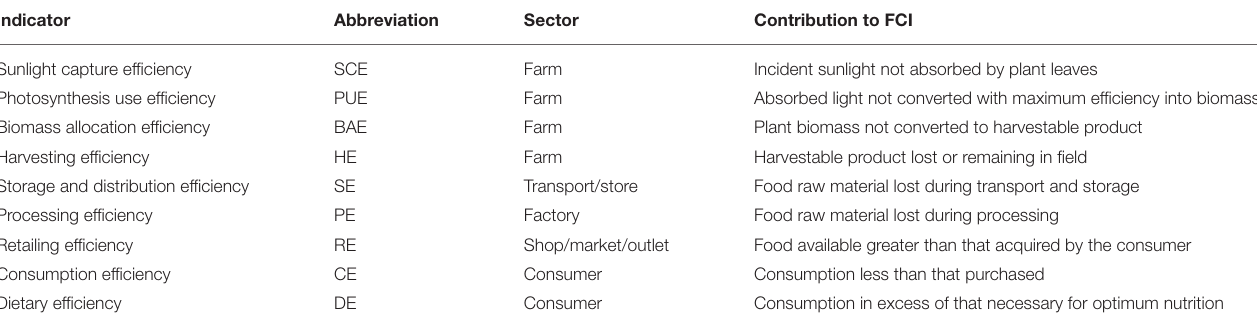
TABLE 1 | The nine indicators of process conversion efficiency that contribute to Food Chain